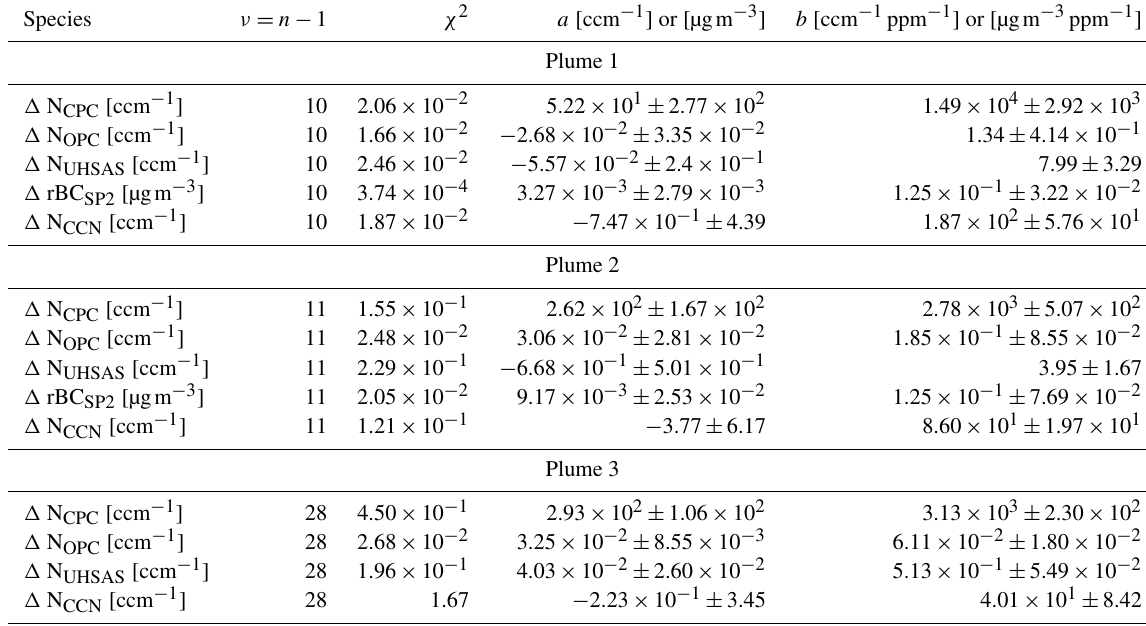
Table 2. Linear regression analysis for excess particle concentration vs. excess carbon dioxide; [ (cid:49)X ] = a + b [ (cid:49) CO 2 ] , where X is any particle concentration; the uncertainty is computed using the orthogonal distance regression (ODR)